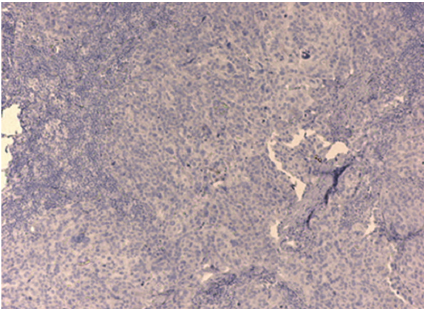
Figure 5: GCDFP-15 negative axillary lymph node.